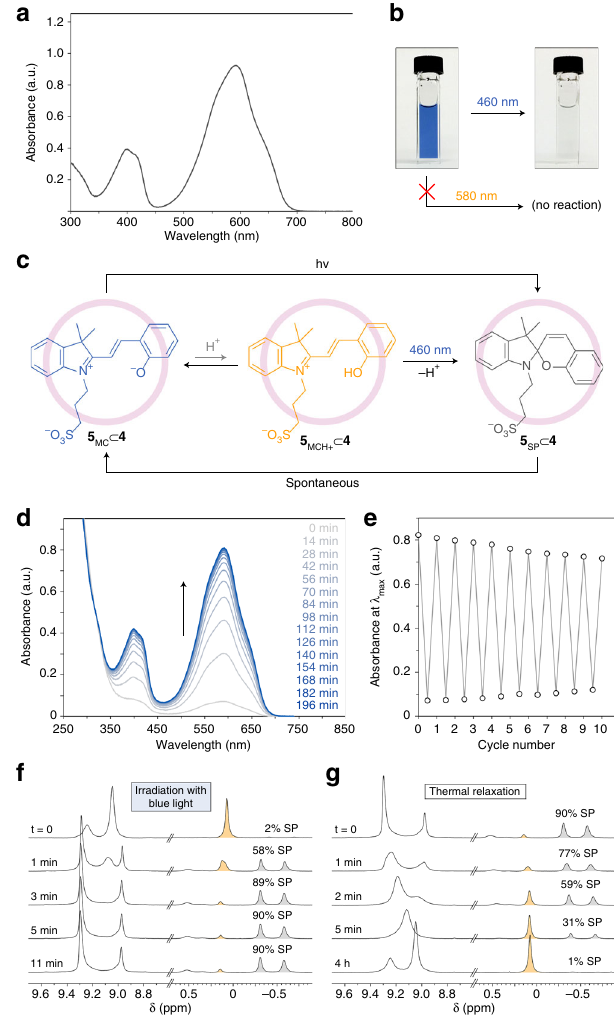
Fig. 4 Photochromism of spiropyran in the cavity of a self-assembled cage. a UV/Vis absorption spectrum of a dilute (0.5 mM) aqueous solution of 5 ⊂ 4 after subtracting the background due to cage 4 . b Ef fi cient decoloration of the blue solution of 5 ⊂ 4 using blue light. c Proposed mechanism of the light- induced decoloration of 5 ⊂ 4 . d A series of UV/Vis spectra of 5 ⊂ 4 accompanying thermal equilibration in the dark (here, t = 0 min corresponds to a solution pre-exposed to blue light). e Reversibility of the light-induced decoloration of 5 ⊂ 4 . f Partial 1 H NMR spectra (400 MHz, D 2 O) of 5 ⊂ 4 during in situ irradiation with blue light for increasing periods of time. The down fi eld-shifted signals are due to 4 ’ s imidazole protons (note the pronounced changes accompanying the isomerization of the bound guest). The up fi eld-shifted signals are due to the methyl groups of encapsulated 5 . The signals highlighted in yellow are due to the MCH + isomer and those in gray are due to SP. g Changes in the 1 H NMR spectra of 5 ⊂ 4 pre-irradiated with blue light upon relaxation in the